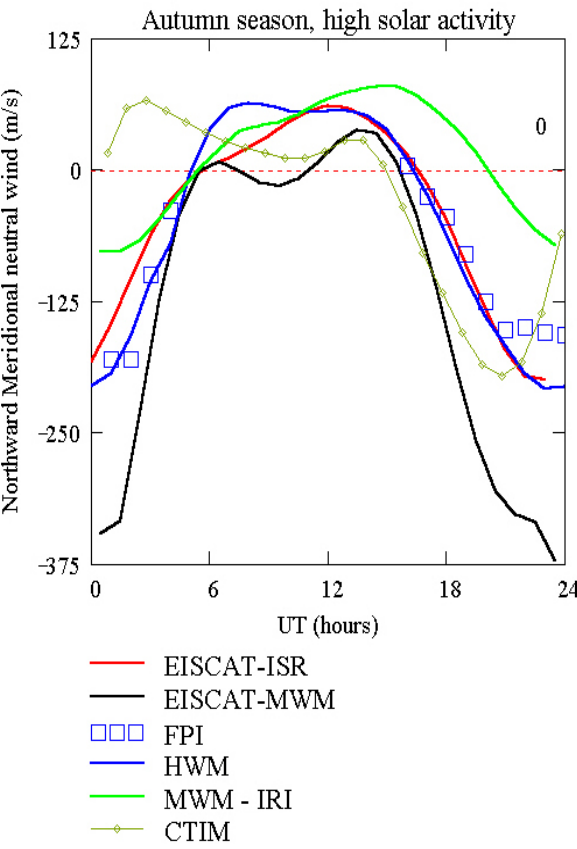
Fig. 7. As for Figure 1 but for autumn season, high solar activity.